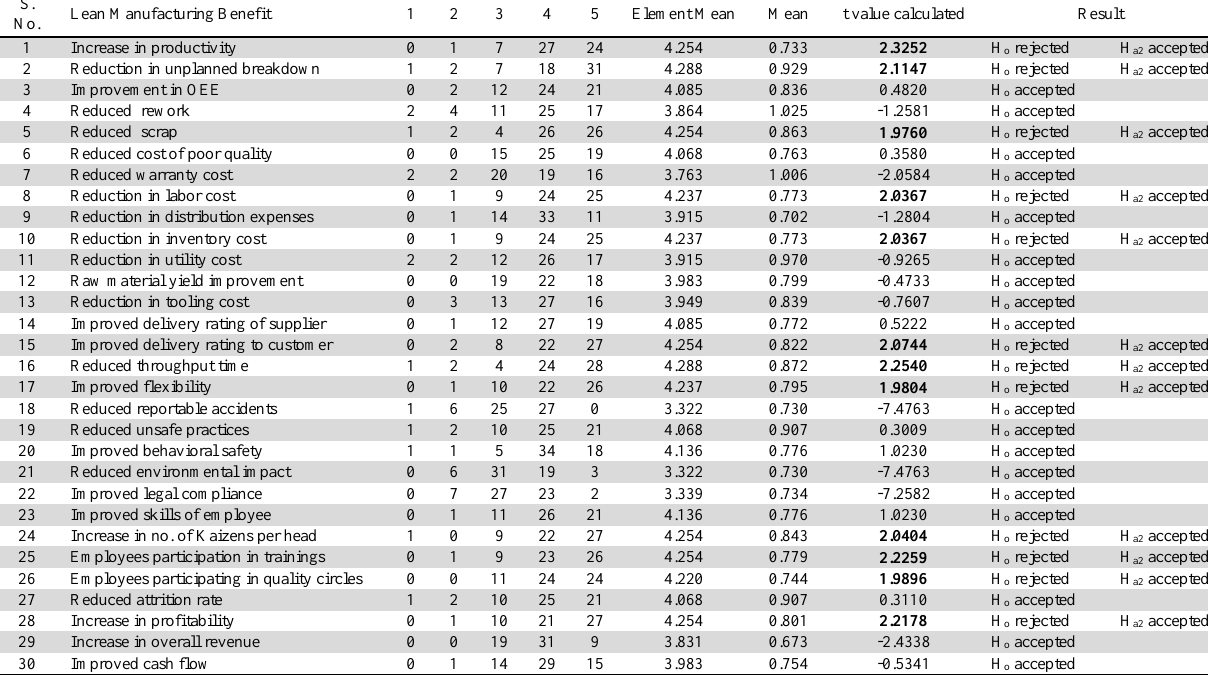
Benefits gained by Indian industry after implementation of Lean manufacturing S.